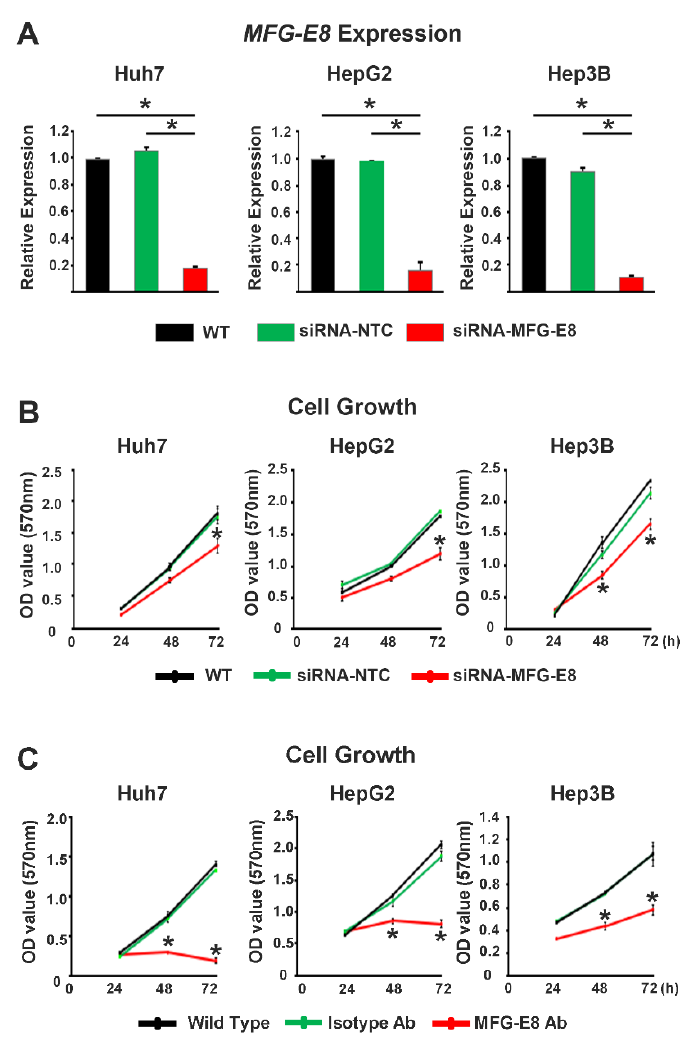
Figure 3. Effects of MFG-E8 knockdown and activity inhibition on HCC cell proliferation. ( A ) The mRNA expression levels of MFG-E8 in HCC cells after transfection with nontargeting control siRNA lentivirus (siRNA-NTC) or MFG-E8-siRNA lentivirus (siRNA-MFG-E8). ( B ) The proliferation of HCC cells was evaluated at different time points in cells transfected with siRNA-NTC or siRNA-MFG-E8. ( C ) Growth curves of HCC cells cultured in the absence (untreated) and presence of isotype control IgG or anti-MFG-E8 antibody (MFG-E8 Ab). * p < 0.05 versus WT, a two-tailed Student’s t -test.